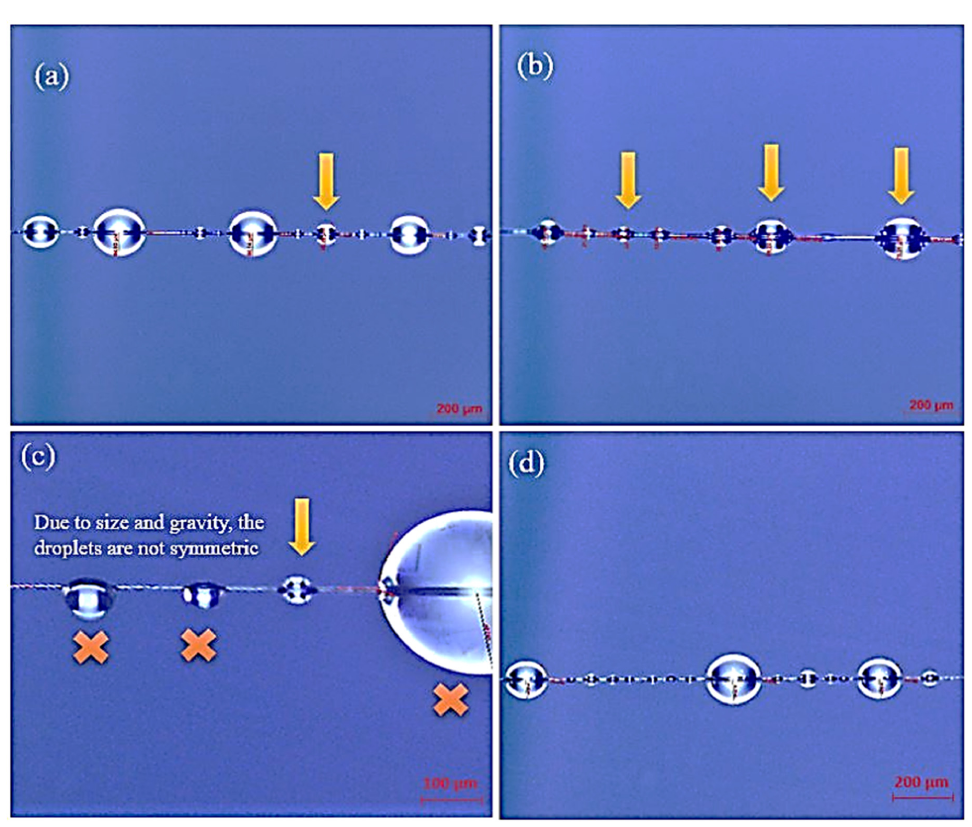
Table 2. Average measured contact angles and average diameter of the measured micro-droplets.